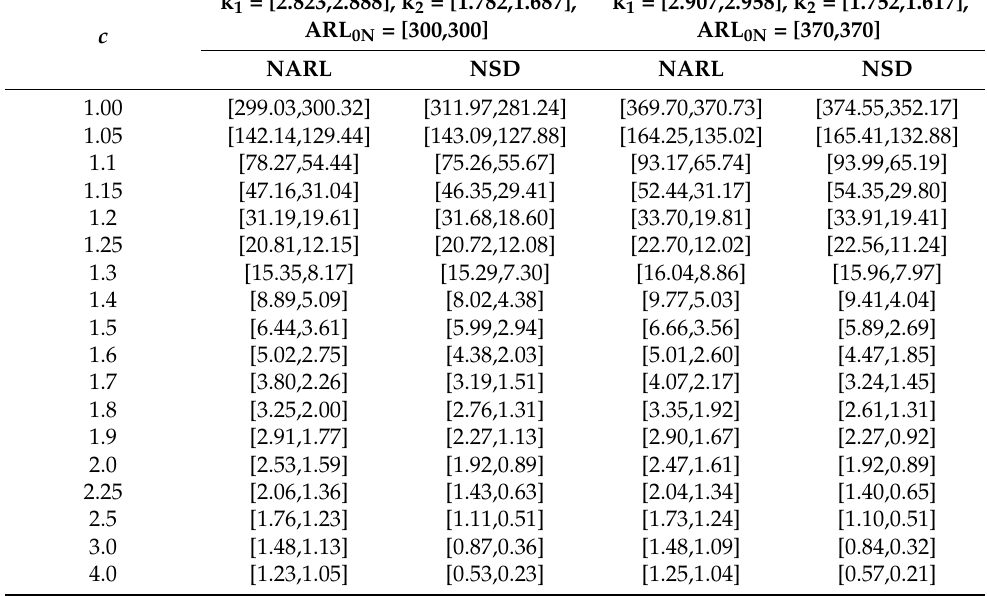
Table 3. The NARL when n N (cid:101) [3,5] and I λ U =